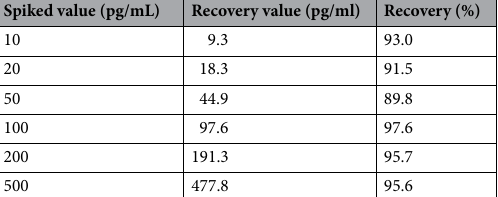
Table 1. Recovery of mouse presepsin from six different spiked